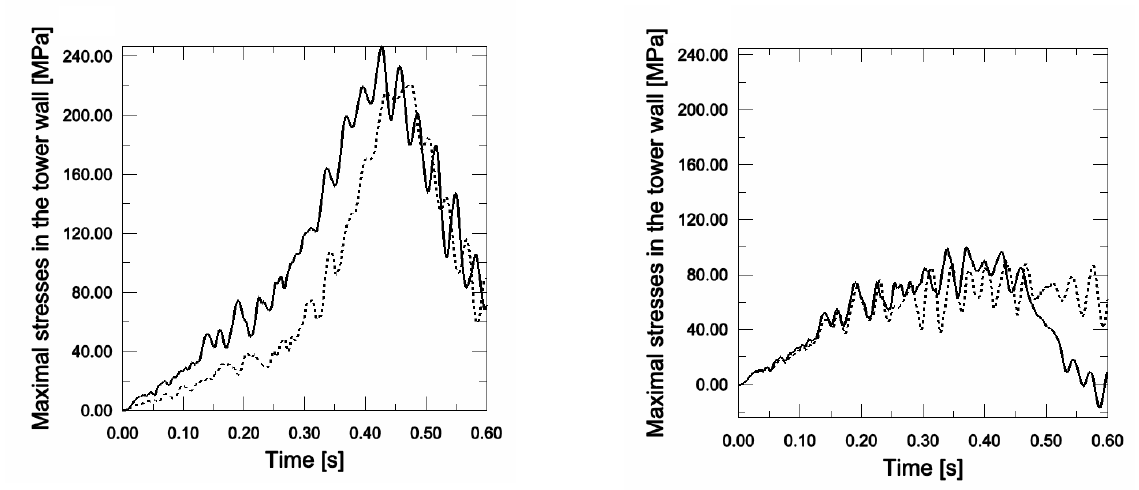
Fig. 11. Stress in tower wall: a) Passive system (continuous line) and semi-active system without pressure release (dashed line), b) Semi-active (continuous line) and active (dashed line) control with pressure release.